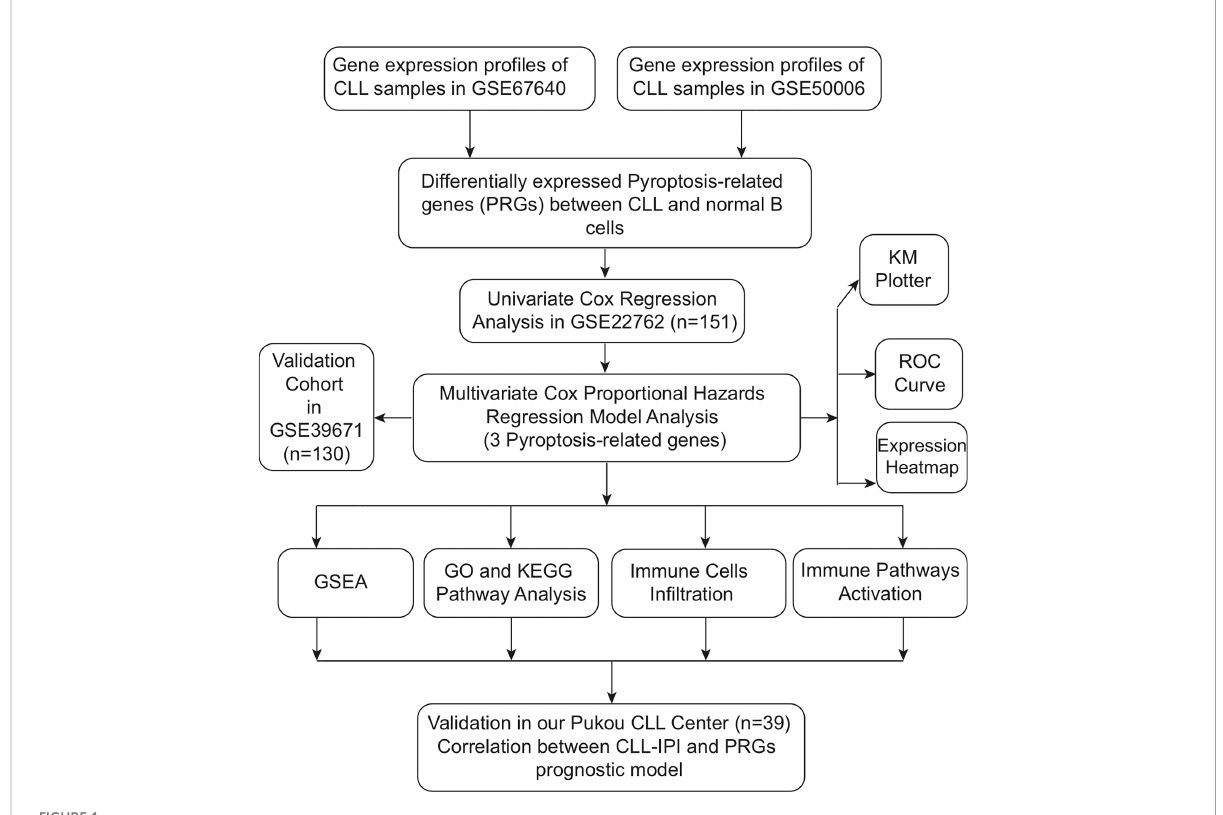
FIGURE 1 Flowchart of this study.